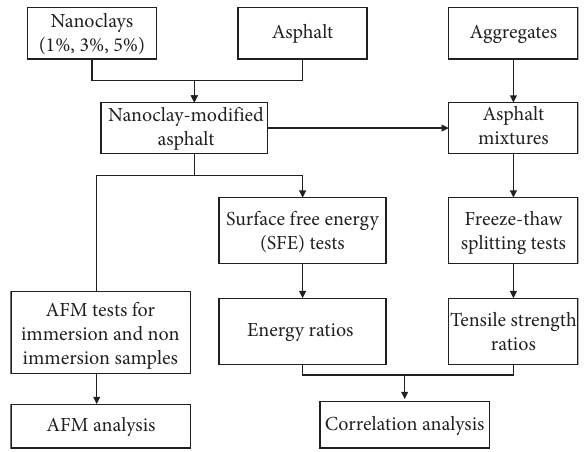
Figure 2: Flow chart for this study.